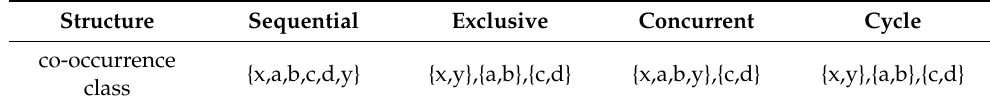
Figure 7. Four basic structures. Table 7. Co-occurrence classes of the four basic